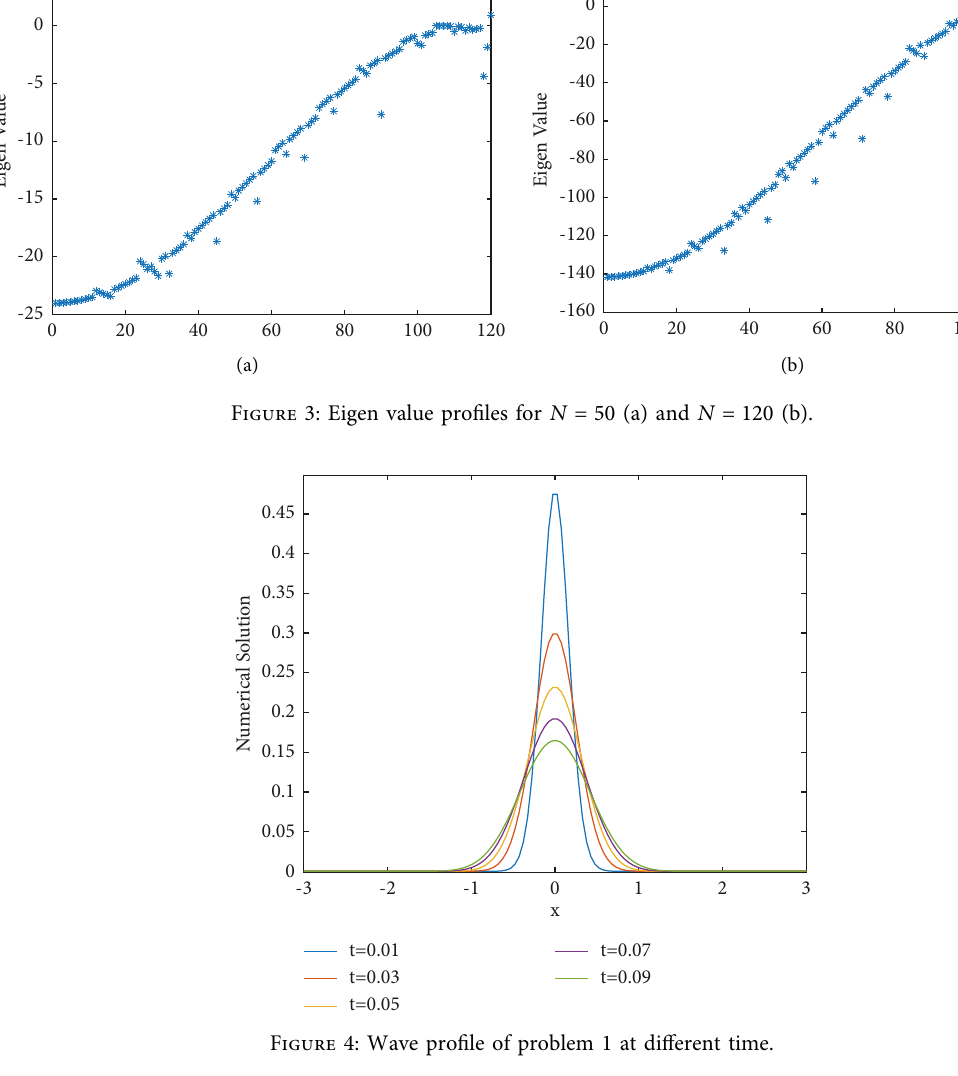
Figure 4: Wave profile of problem 1 at different time.